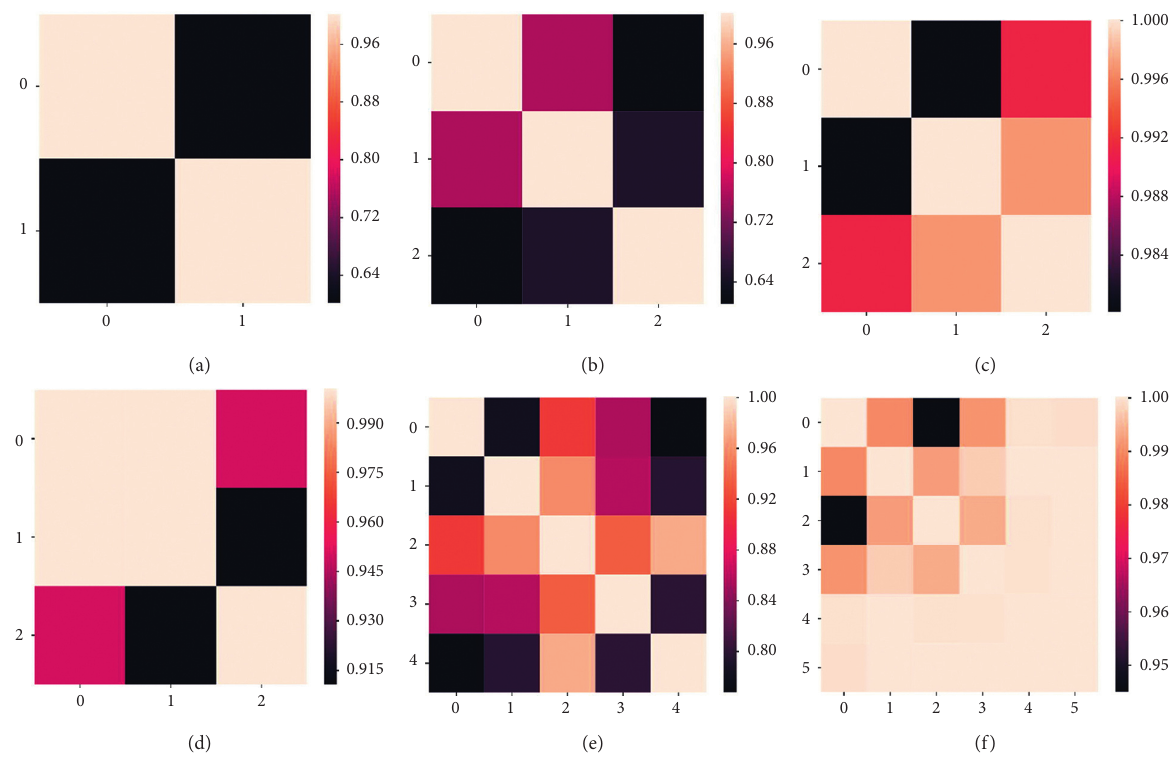
Figure 4: The interlayer similarity illustration of multiplex networks in 6 real-world datasets. The distribution visualization of shared and complementary information among all layers in different multiplex network datasets contains Ack-Co-author multiplex network, CKM physicians innovation multiplex network, London multiplex transport network, VICKERS classroom social multiplex networks, CS-Aarhus social multiplex networks, and Celegans multiplex gpi network. (a) Ack-Co-author. (b) CKM. (c) London. (d) VICKERS. (e) CS-Aarhus. (f) Celegans.